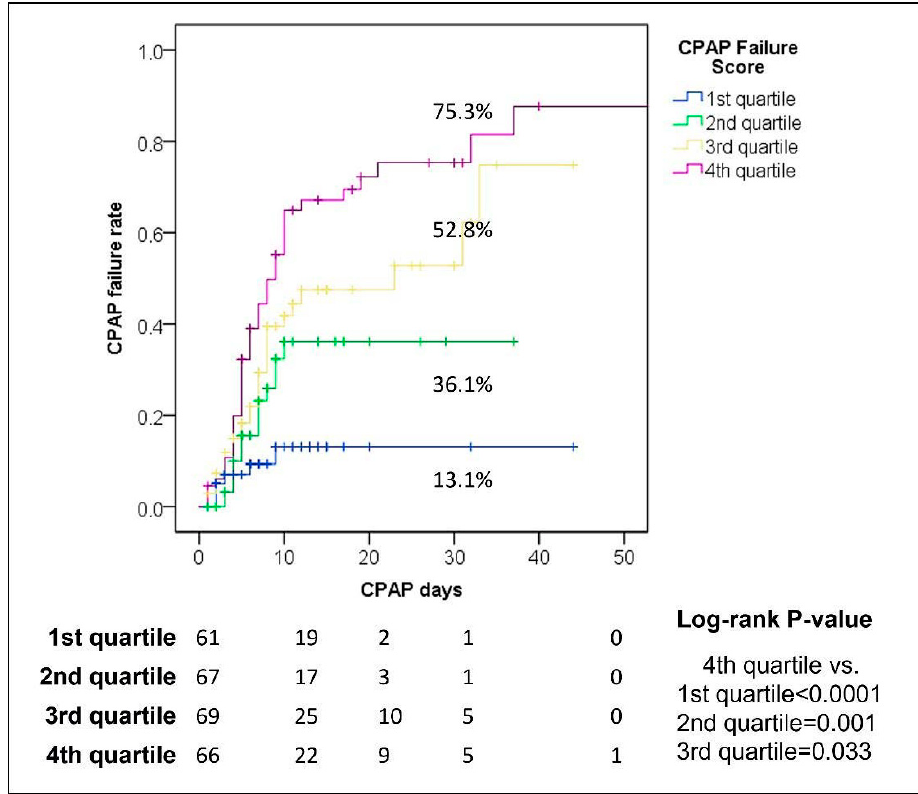
Figure 1. Different CPAP failure rates in the different sub-classes of CPAP Failure Score.